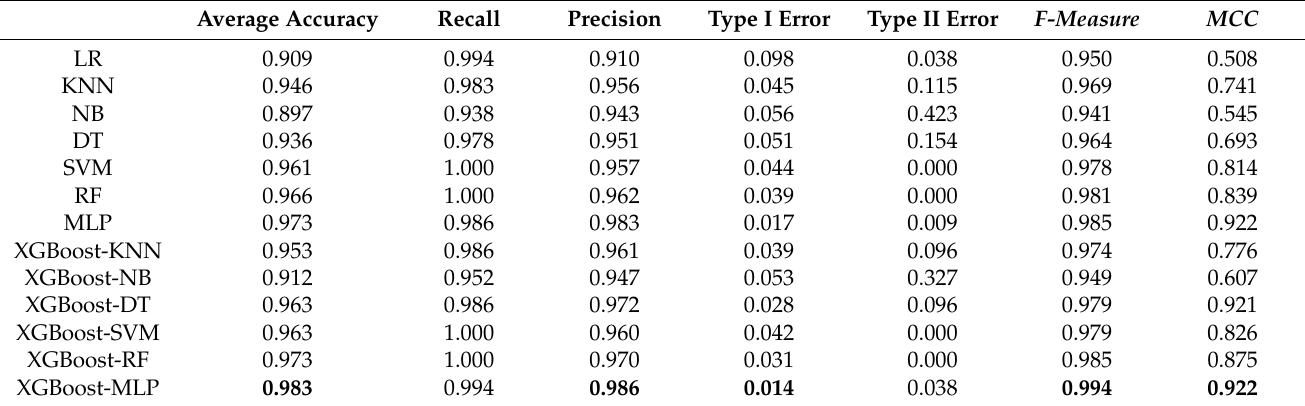
Table 4. Performance of XGBoost-MLP and other machine learning methods. (Out-of-sample).